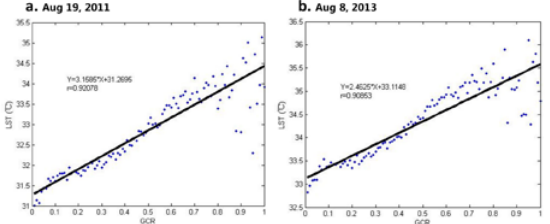
Figure 5. Relationship of mean LST to ground coverage